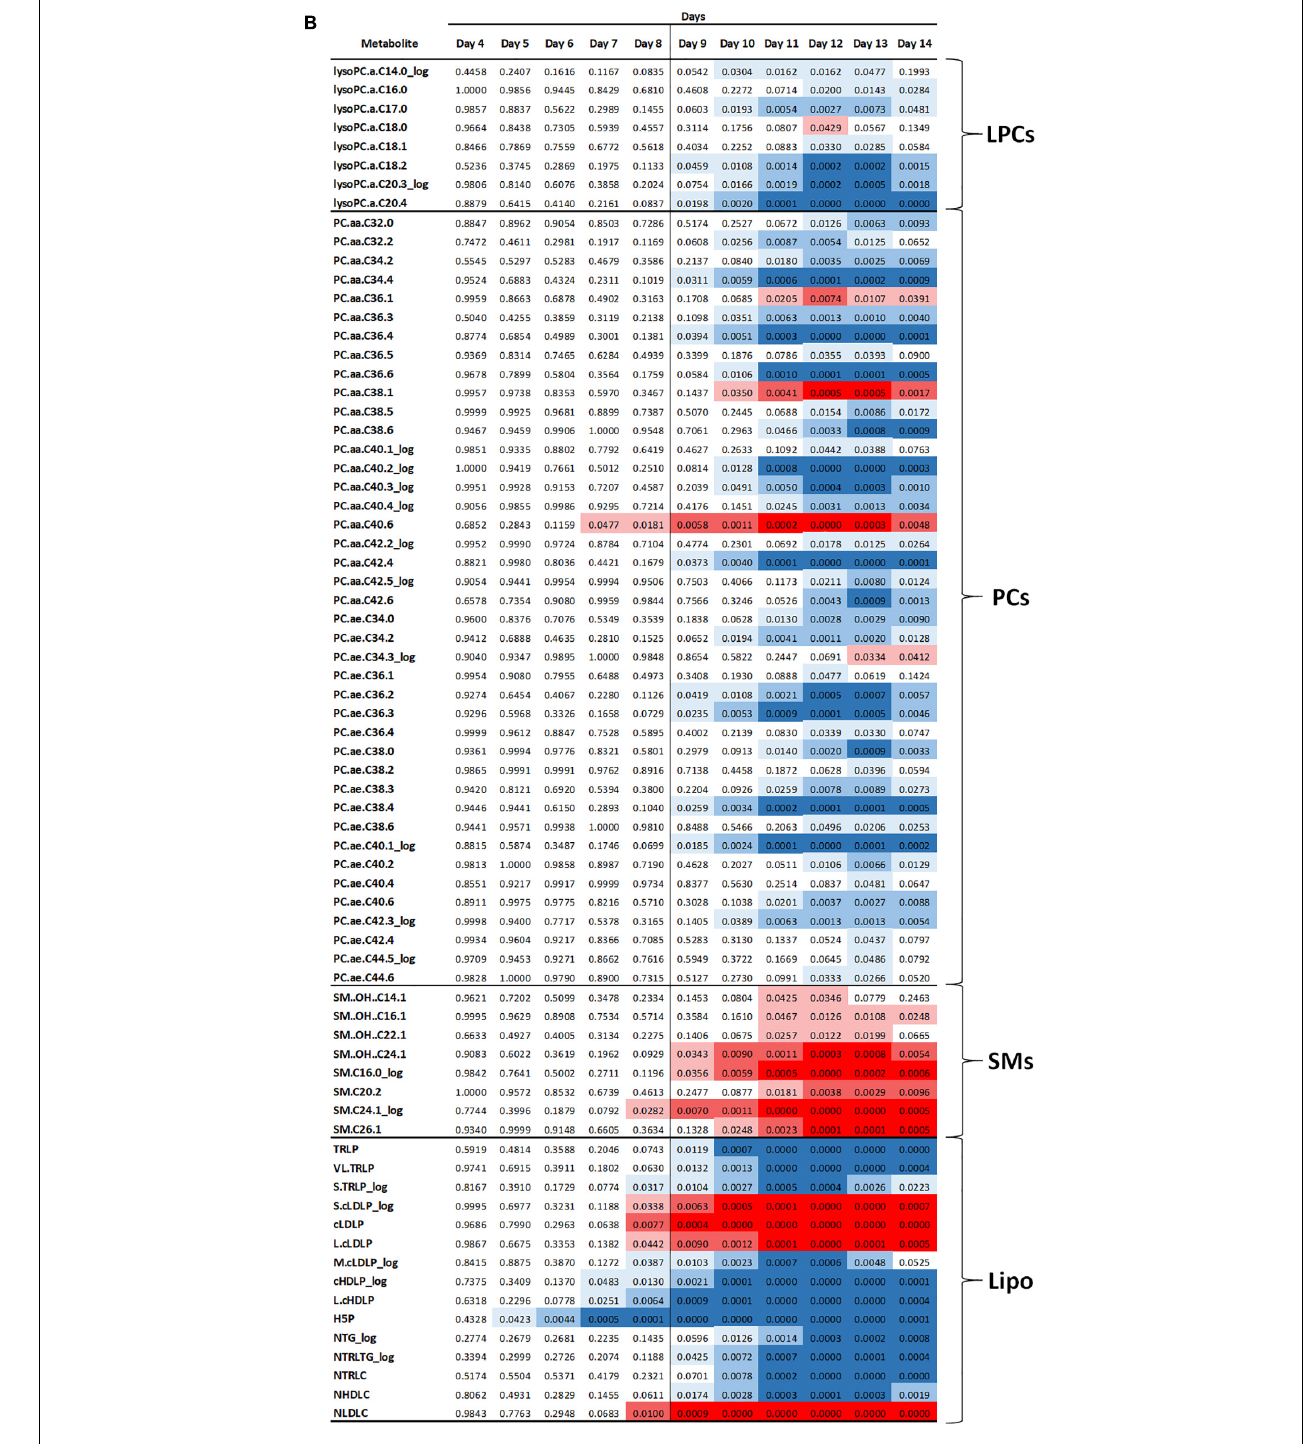
FIGURE 2 | Heatmap of p -values for the significantly altered metabolites starting at day 4. Blue color indicates that the metabolite concentrations were reduced in the cachectic mice and red indicates that the concentrations were increased. Darker shading indicates more significant changes, i.e., lower p -values. (A) Data for amino acids (AA), acylcarnitines (AC), and miscellaneous metabolites (Misc). (B) Data for lipid related metabolites including lysophosphocholines (LPC), phosphocholines (PC), sphingomyelins (SM), and lipoproteins (Lipo).